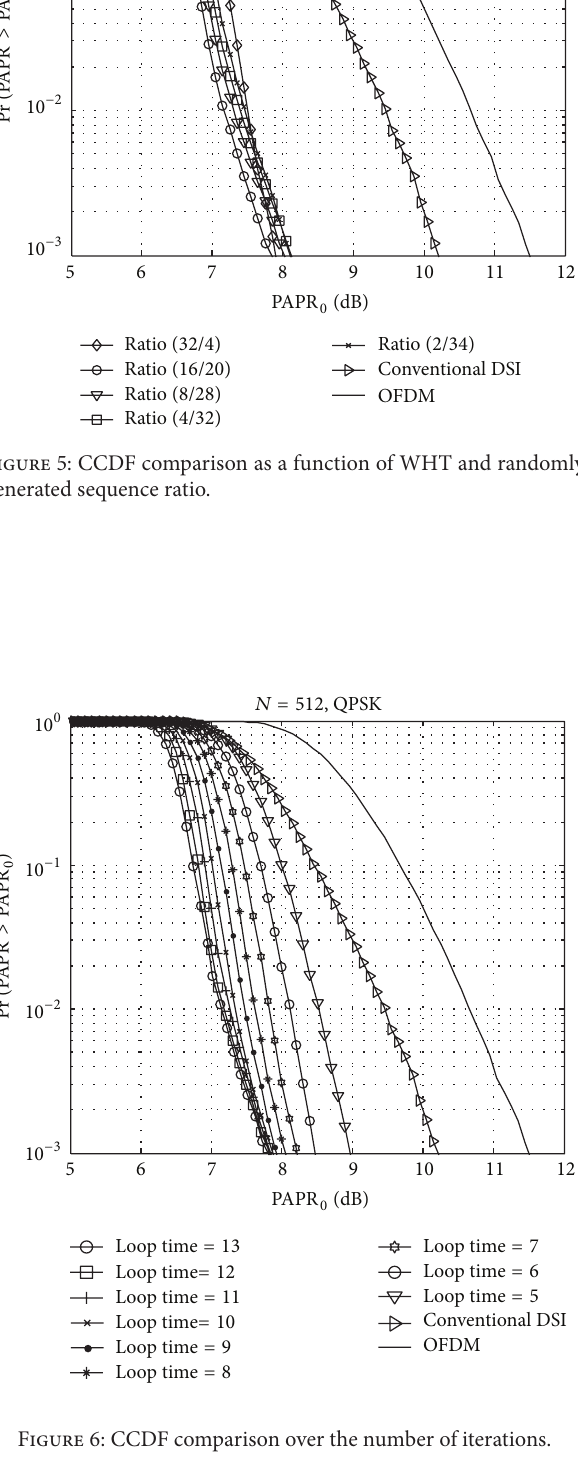
Figure 6: CCDF comparison over the number of iterations.